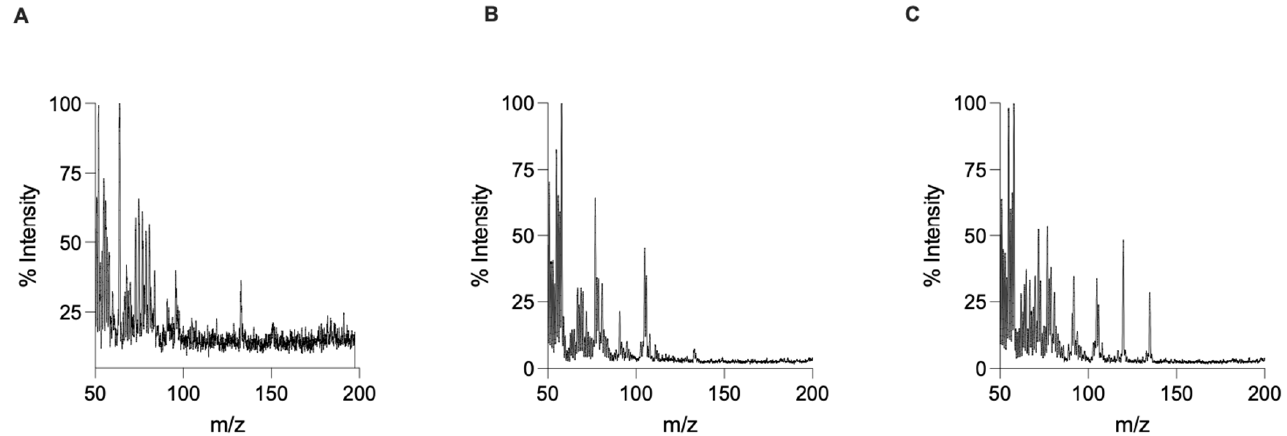
Figure 2. Representative mass spectra of ( A ) control (LB media), ( B ) S. epidermidis , and ( C ) P. aeruginosa from undiluted overnight cultures.